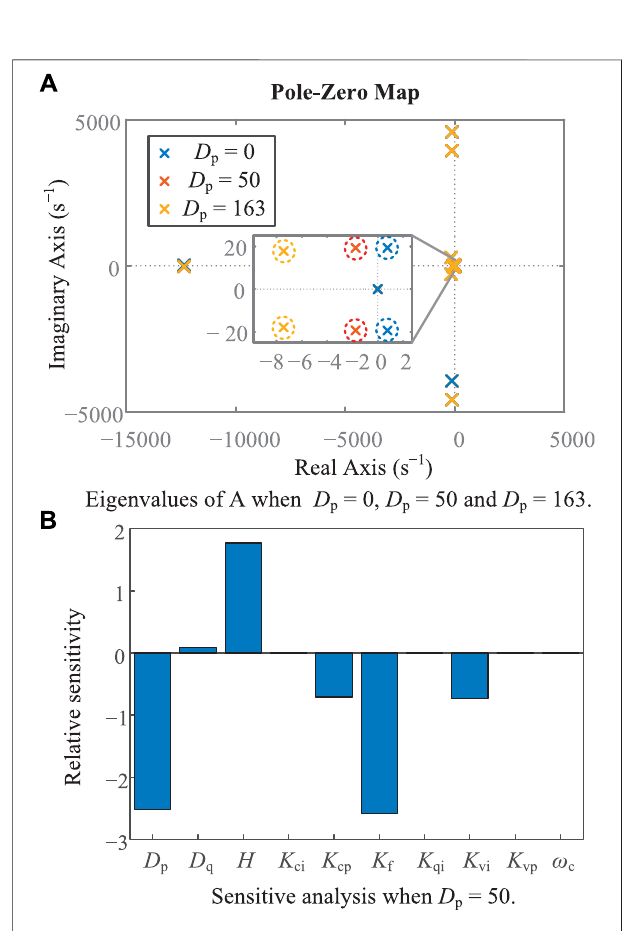
FIGURE 5 | Eigenvalues and sensitivity analysis of A